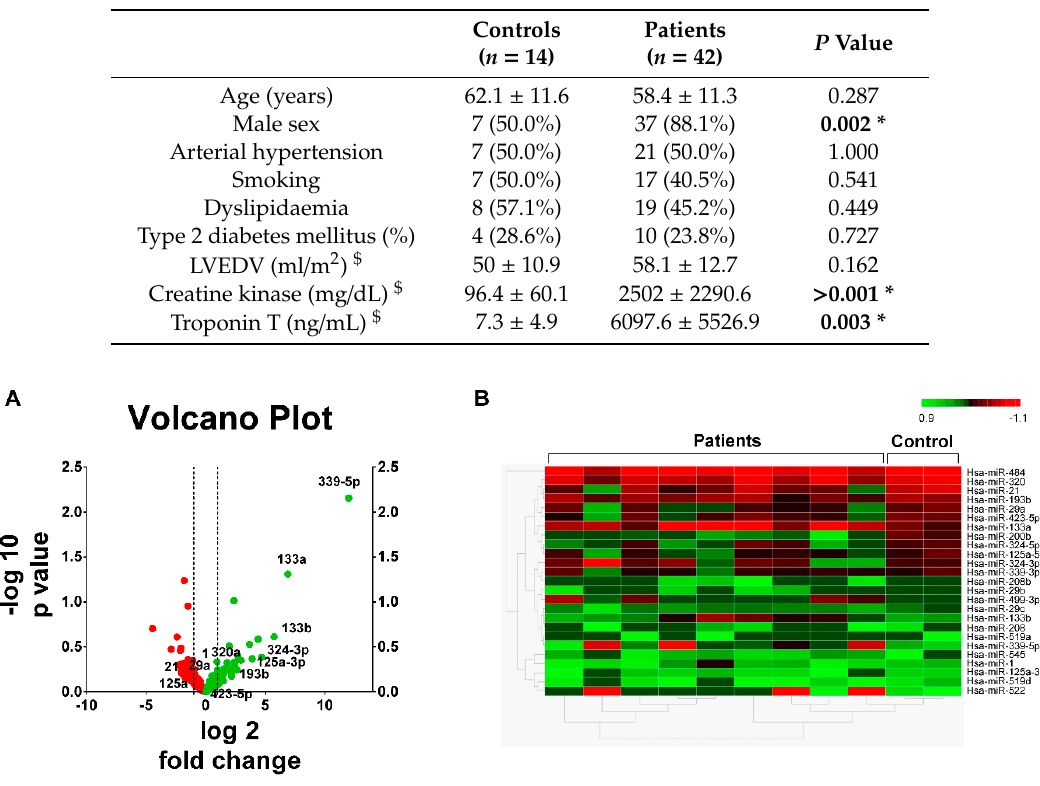
Figure 1. miRNAs di ff erentially expressed in STEMI patients 3 h post PPCI. ( A ) Volcano plot showing miRNAs di ff erentially expressed in STEMI patients ( n = 9) relative to the control ( n = 3); the x axis shows log 2 (fold change), and the y-axis shows –log 10 ( p value). ( B ) Fragment of hierarchical clustered sample-centric heat-map analysis of the ∆ Ct value of di ff erentially expressed miRNAs in STEMI patients 3 h post PPCI compared to the control. Scale bar: downregulated (red) and upregulated (green). Distance was measured by Pearson’s correlation.